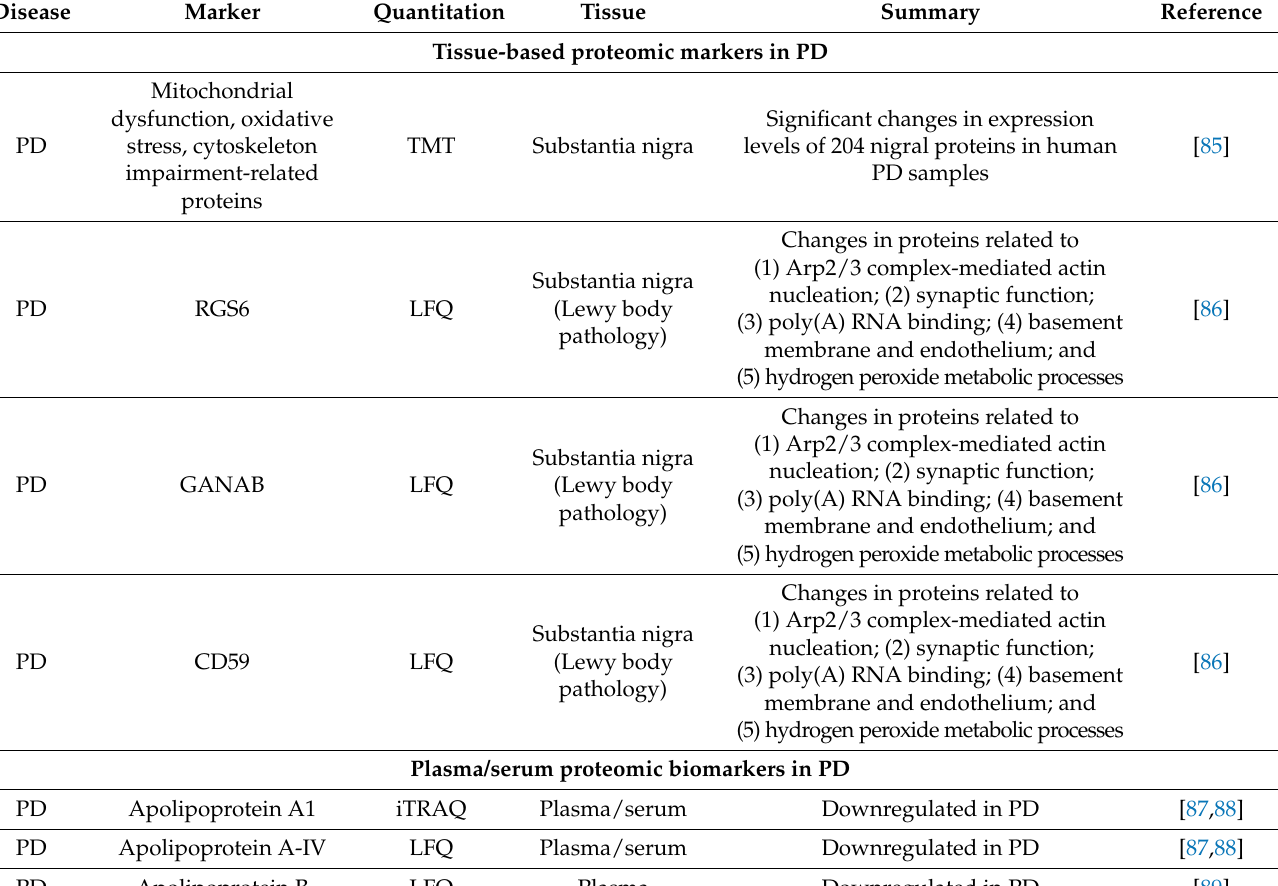
Table 3. Proteomic studies in PD focused on biomarker